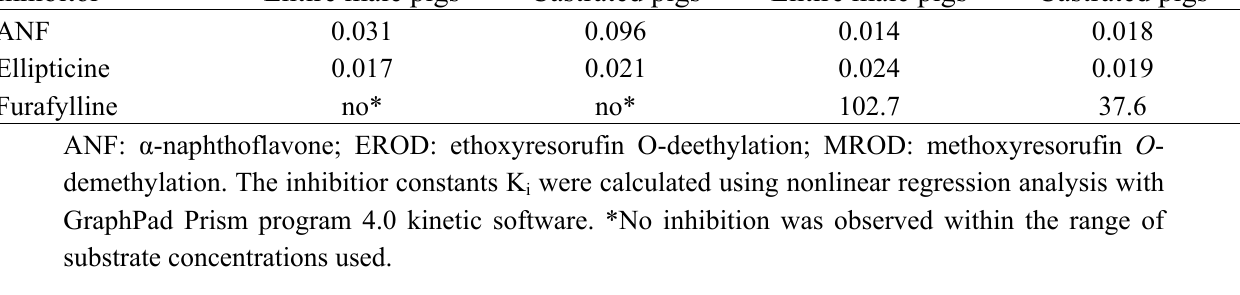
Table 4. Inhibition constants of ANF, ellipticine and furafylline for EROD and MROD in the microsomes from castrated and entire male pigs. Ki, µM EROD MROD Inhibitor Entire male pigs Castrated pigs Entire male pigs Castrated